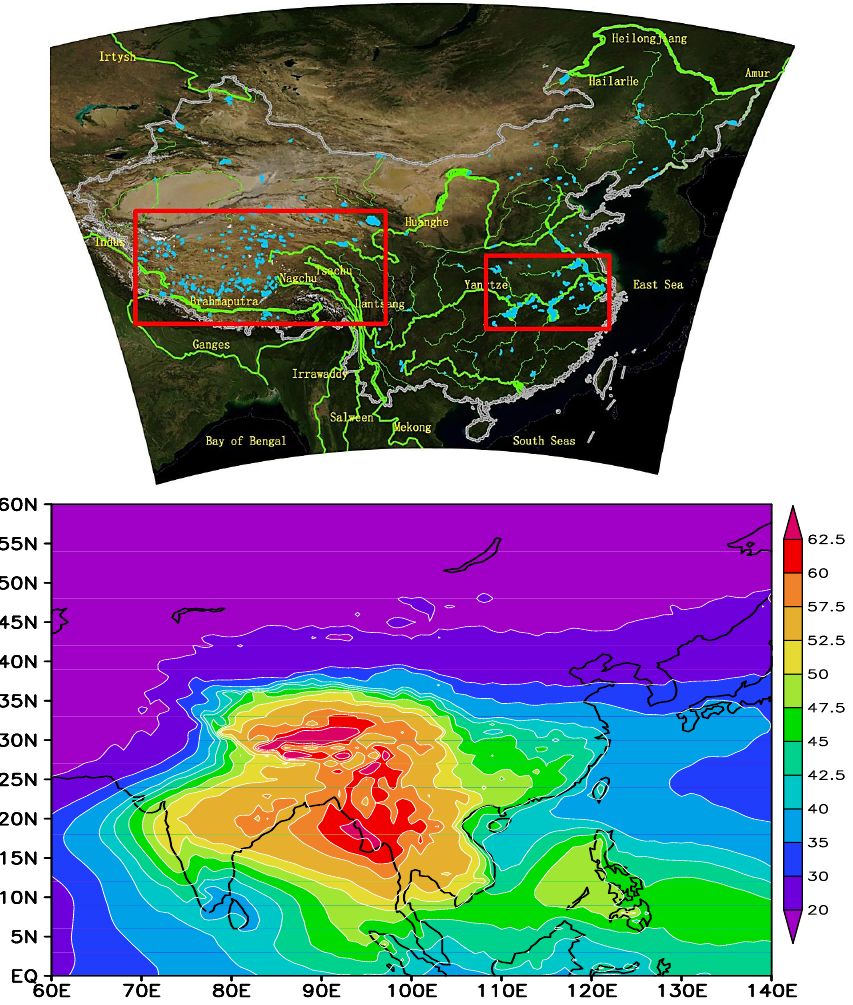
Figure 1. Geographical distribution of water sources in glaciers (snowpack), rivers and lakes over China with white, green and light blue colors, respectively. Two major lake groups are marked by two red rectangles in the TP and eastern China (upper panel). Column vapor content (10 − 2 gcm − 2 ) over 500hPa in summer averaged over 2000–2009 (lower